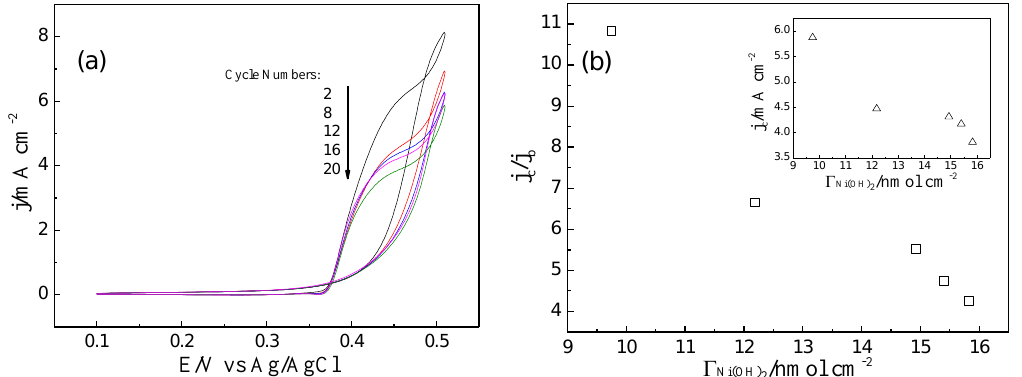
Scheme 1. Reaction mechanism of benzyl alcohol electrooxidation mediated by Ni(OH) 2 .